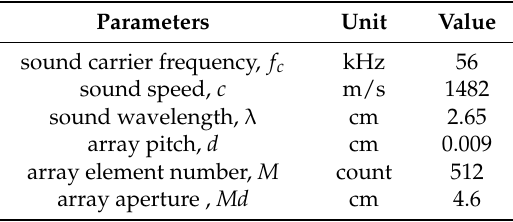
Table 1. List of System